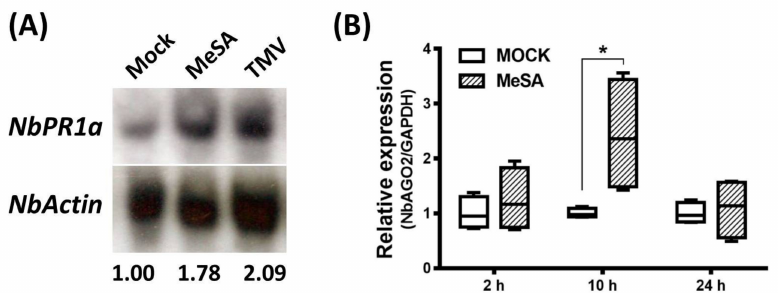
Figure 4. Exogenous spray of MeSA induced NbAGO2 expression. ( A ) 500 µ M of MeSA was sprayed on N. benthamiana leaves and the leaves were collected at 10 h post spray. Total RNAs were isolated and NbPR1a level was determined by Northern blot experiment using NbPR1a sequence specific probe. The same blot also includes the TMV infected leaf sample after 10 h of infection. NbActin served as internal control and its mRNA level was evaluated by same way using NbActin specific probe. The number below the panel indicates the ratio of the blot band intensity between NbPR1a and NbActin , in which the ratio in first lane was arbitrarily defined as 1. ( B ) The same leaf tissues treated by MeSA were collected at di ff erent time points and NbAGO2 expression was determined by quantitative real-time PCR. Plants sprayed with water solution served as control treatment. NbAGO2 expression in control was arbitrarily designated as 1. N. benthamiana GAPDH gene served as the internal control. Significant di ff erences between groups were calculated by Student’s t -test. Single asterisk indicated significant di ff erence at p < 0.05.